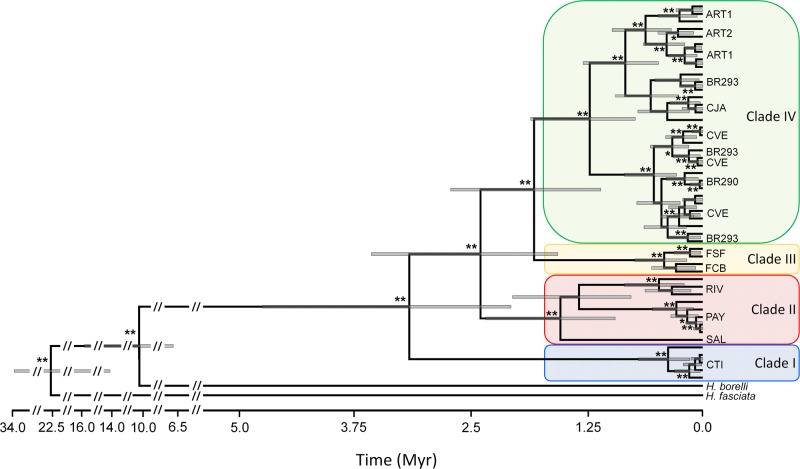
A time-calibrated Bayesian evolutionary tree produced in BEAST (see text for details).**posterior probability (PP) > 0.95; *PP > 0.90. Time is given in millions of years (Myr). The bars for each node represent the 95% credible interval for the time of the most recent ancestor (TMRCA). Clades I-IV are shaded in agreement to Fig. 1.